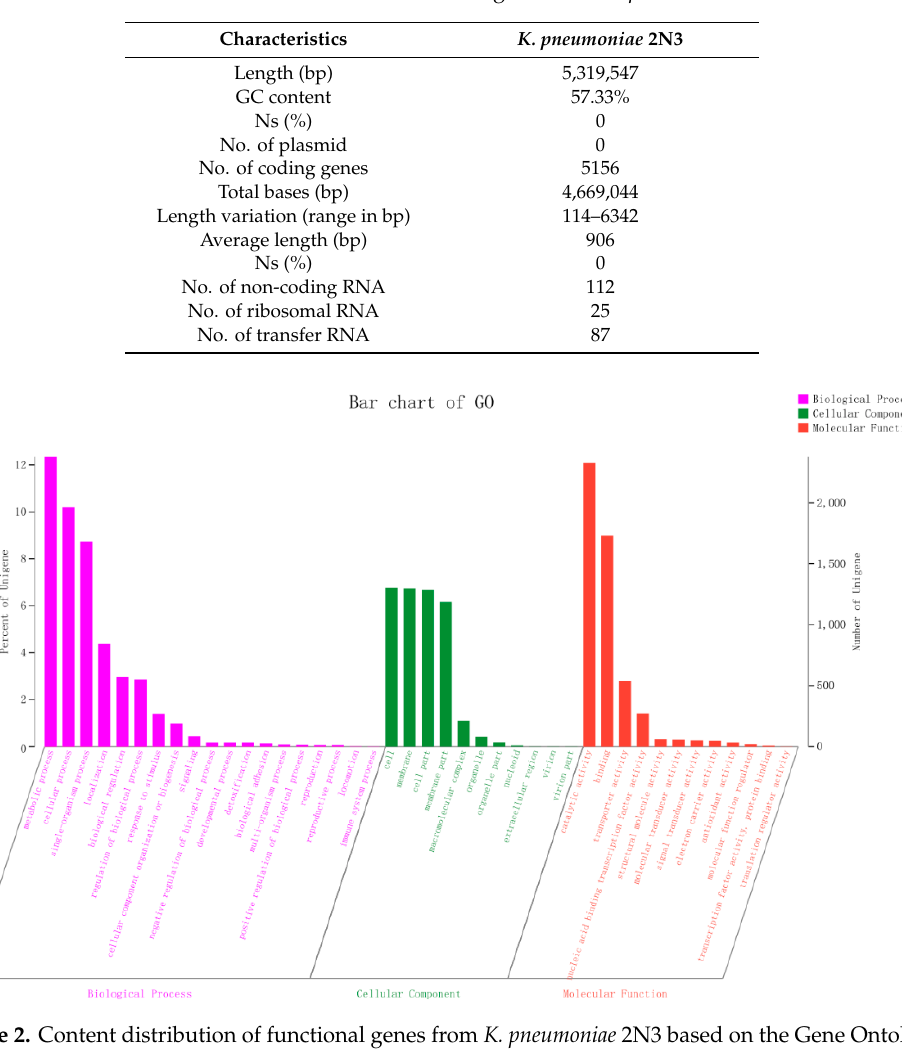
Figure 2. Content distribution of functional genes from K. pneumoniae 2N3 based on the Gene Ontology (GO) database.